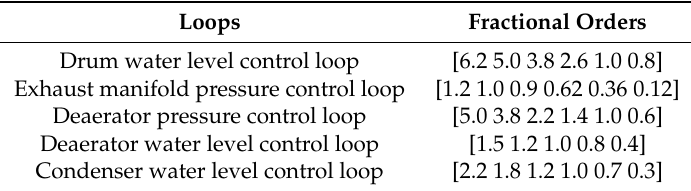
Table 3. Different fractional orders for the five